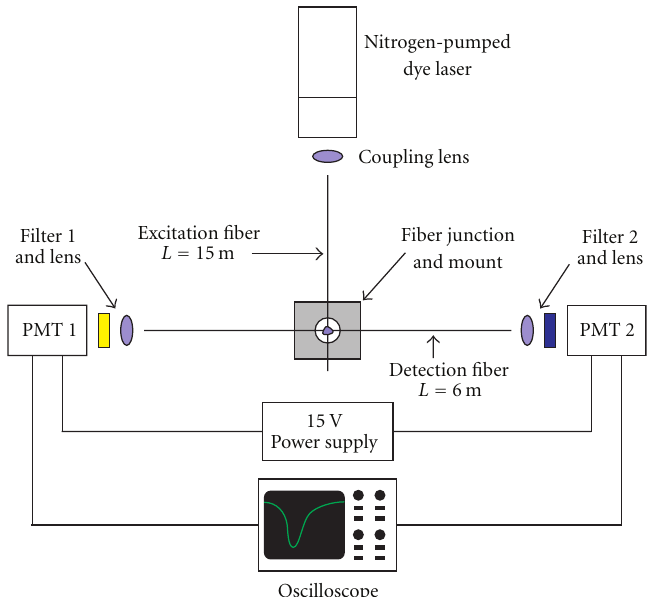
Figure 2: Optical setup for fluorescence measurements with a crossed-fiber pH